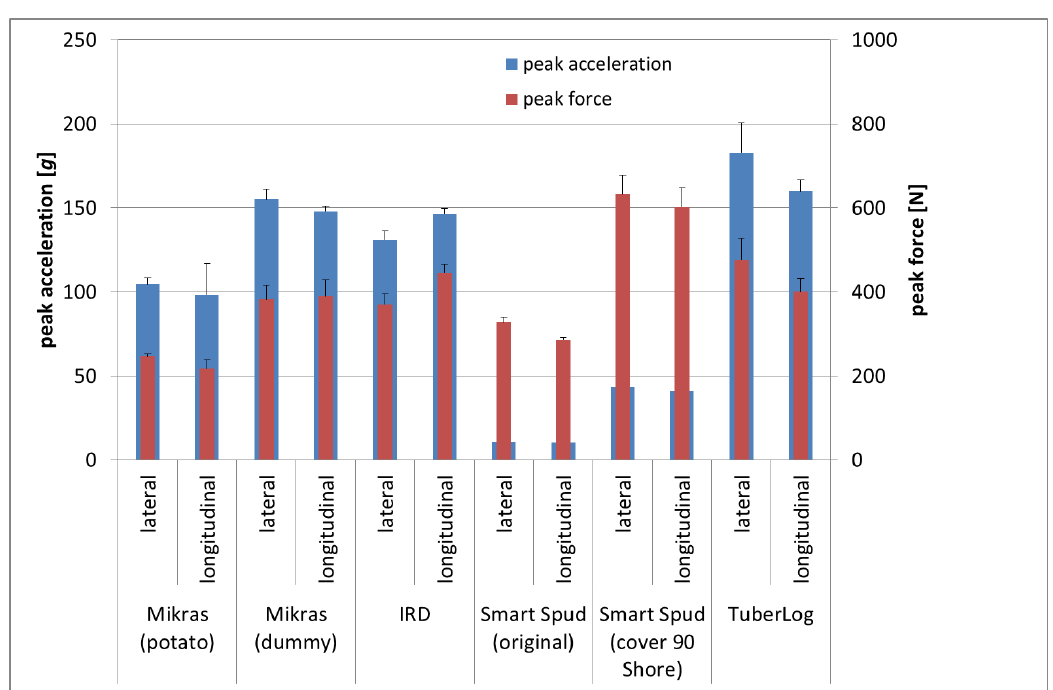
) to calculated peak force m